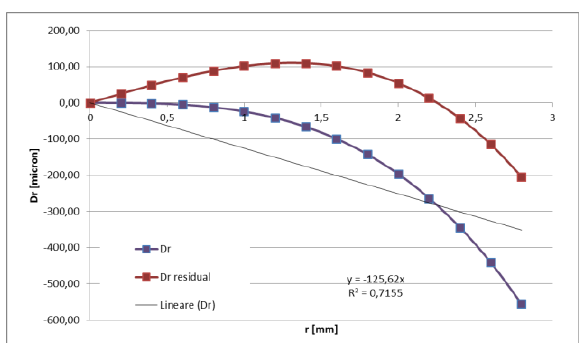
Figure 4 - Results of the radial lens distortions of GoPro